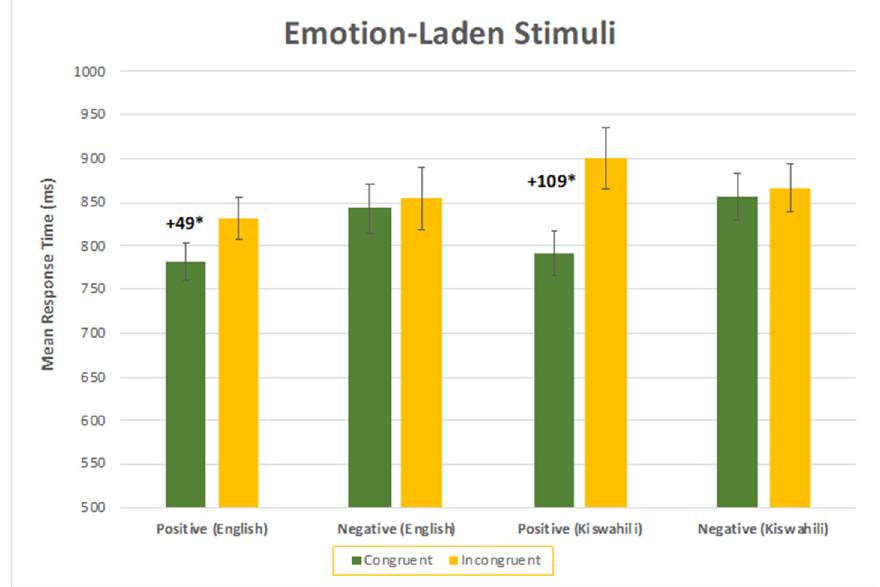
Figure 2. Mean response times for emotion-laden words. * Indicates p < 0.05.